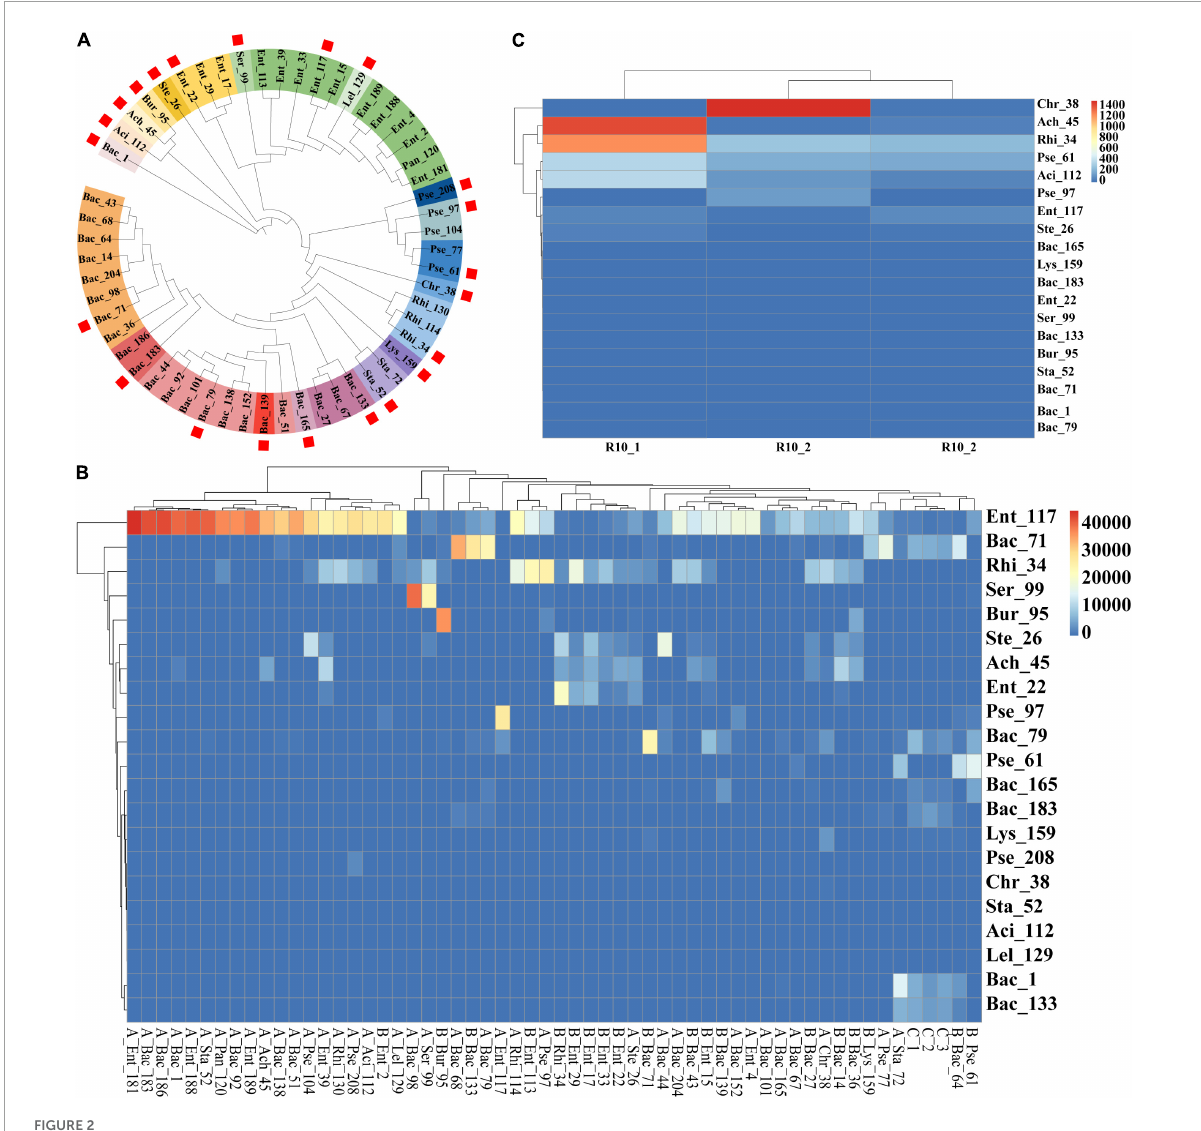
FIGURE2 High-throughput sequencing of wheat and healthy tomato and heatmap of 55 single bacteria. High-throughput sequencing data of 55 infected wheat roots and the data of healthy tomato roots were mapped with a similarity of 97% with the representative sequences of 55 monocultures, respectively. (A) Screening dendrogram of representative sequences of 55 single bacteria. The representative sequences of the 55 single strains were screened, and each sample was blasted with the other samples. The similarity between the representative samples and the samples within the group was more than 99%, and the similarity between the samples within the group was more than 98%. A kind of color represents a set of representative sequences, and samples marked with squares are representative strains. (B) Heatmap of high-throughput data and representative sequences with 55 infected wheat roots. (C) High-throughput data within healthy tomato roots and heatmap of representative